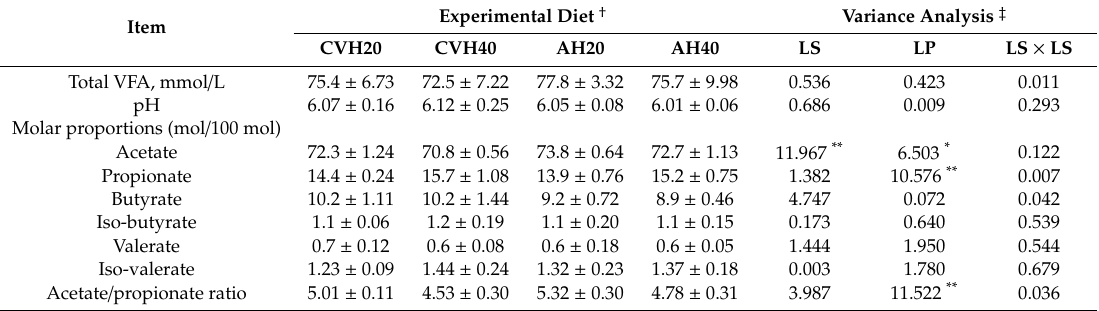
Table 5. E ff ects of di ff erent diets on the ruminal fermentation parameters in Simmental crossbred cattle. Experimental Diet † Variance Analysis Item